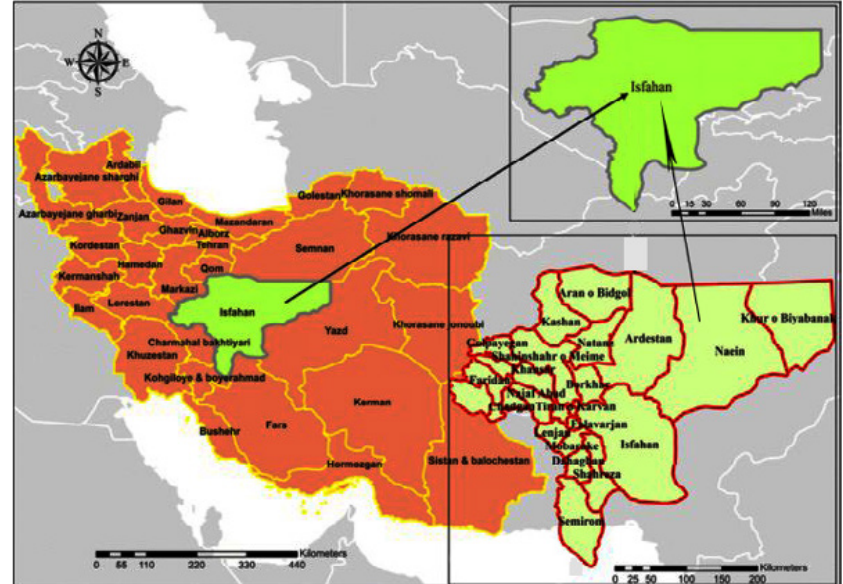
Fig. 1: Geographic llocation of the study area in Naeen City, Fig 1: Geographic llocation of the study area in Naeen City, Iran